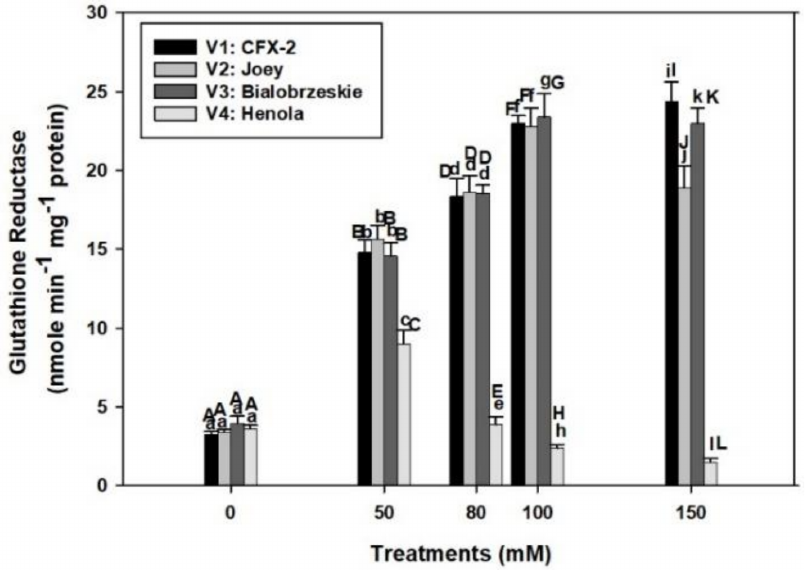
Figure 4. Effects of NaCl on IH root GR specific activity. Vertical bars represent SE. Different capital letters indicate significant differences among the varieties and lower case letters represents significant treatment differences. These mean values ( n = 15) are separated using LSD at p <